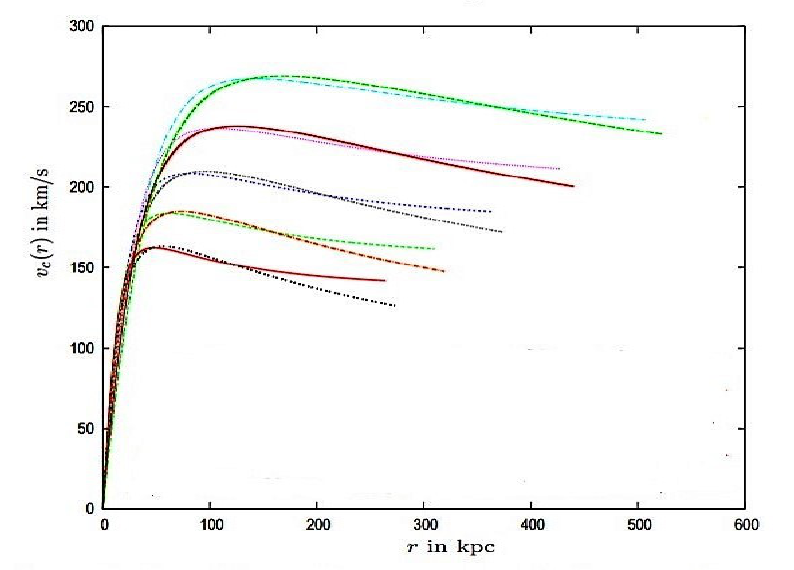
Figure 4. The universal rotation curve of spirals compared with the predictions of the 2 keV WDM scenario (that flattens at outermost radii)